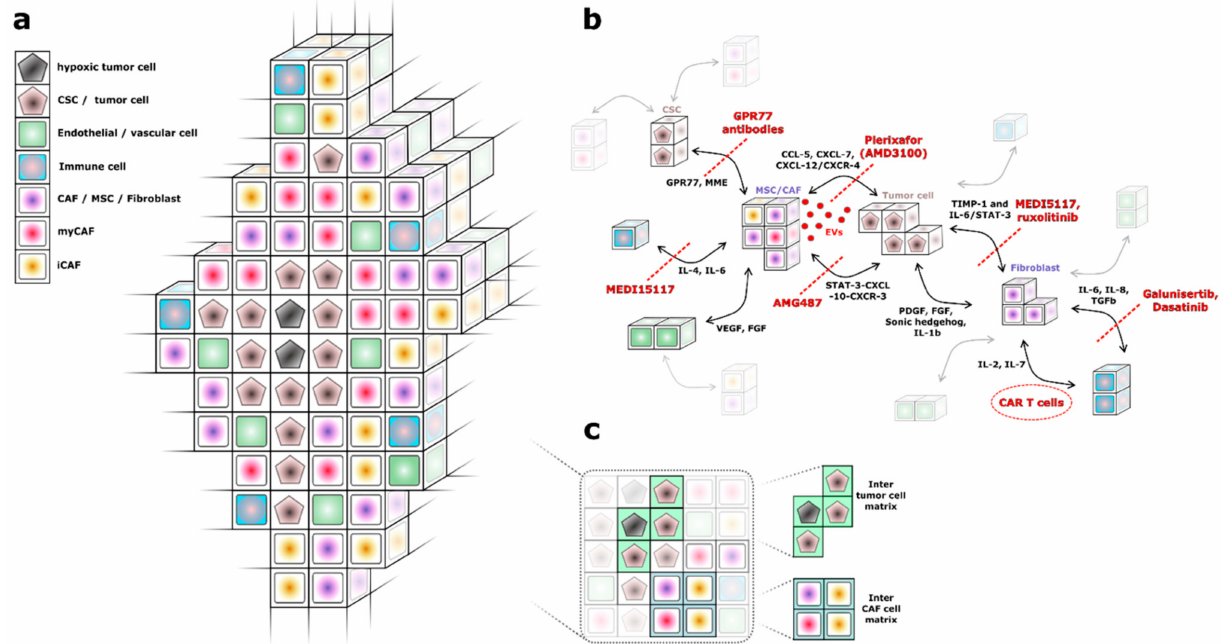
Figure 1. ( a ) Model of tumor cells and cells of the tumor microenvironment (TME). The TME contains multiple cell types of diverse origins (endothelial, immune, fibroblastic) but the location of specific subtypes is characteristic of certain cancer-associated fibroblast (CAF) subtypes (myofibroblastic CAFs (myCAFs), adjacent to tumor, and “inflammatory” CAFs (iCAFs), in the TME periphery). ( b ) Complex crosstalk between different cells (tumor cells and TME cells) yields several specific targets for the inhibition of tumor growth by specific molecules. However, several intercellular interactions of TME cells have not yet been studied in sufficient detail to establish an adequate target strategy (e.g., immune cells and vascular cells). ( c ) The extracellular matrix is depicted in this subfigure. The matrix accounts for a large part of the TME and represents a potential therapeutic